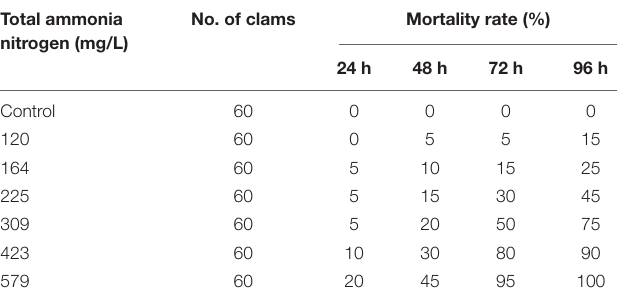
TABLE 2 | Mortality of S. constricta exposed to total ammonia nitrogen during 96 h